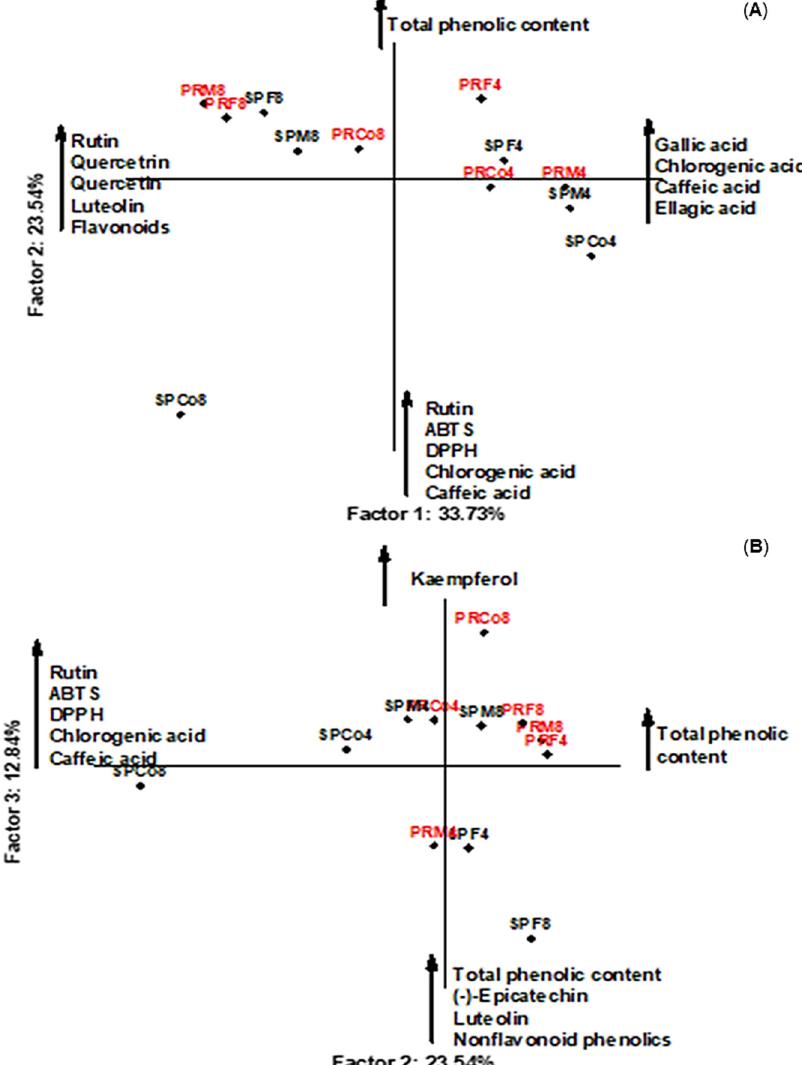
Figure 2. Principal component analysis (PCA) of B. trimera and B. myriocephala ethyl acetate fractions according to the levels of bioactive compounds and antioxidant activity: PC1 vs. PC2 ( A ) and PC2 vs. PC3 ( B ). Co = commercial samples, F = female specimens, M = male specimens, SP = São Paulo state, and PR = Paran á state. The presented numbers are related to the pH conditions used to obtain each